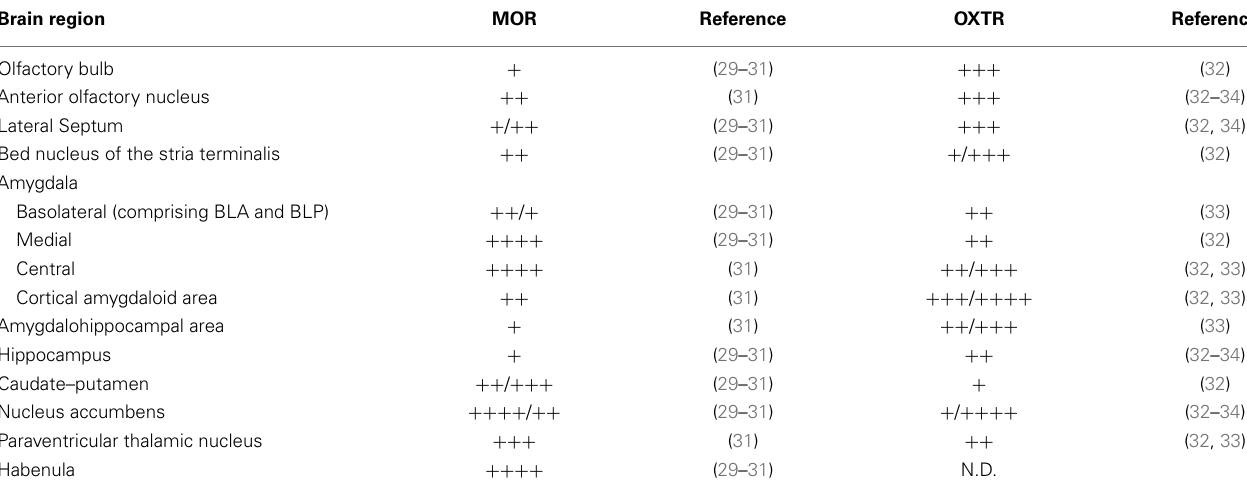
Table 1 | MOR and OXTR expression levels in mouse brain as reported in the literature